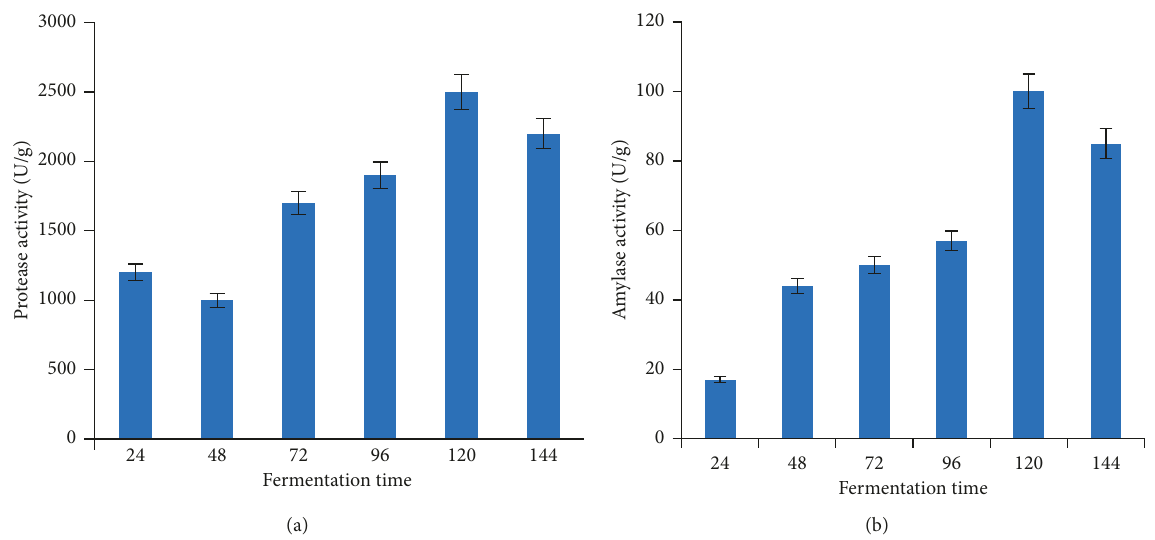
Figure 2: Effect of incubation period ( h ) on the production of protease (a) and α -amylase (b) by R. oryzae CH